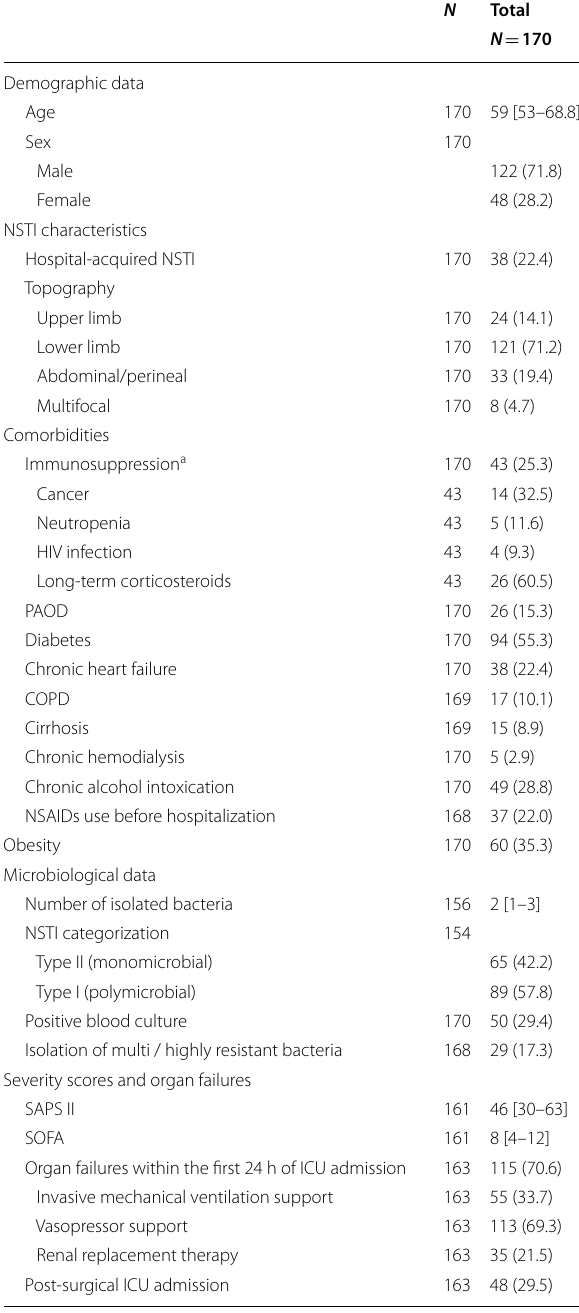
Table 1 Characteristics of patients with necrotizing soft tissue infections ( n 170) at intensive care unit =